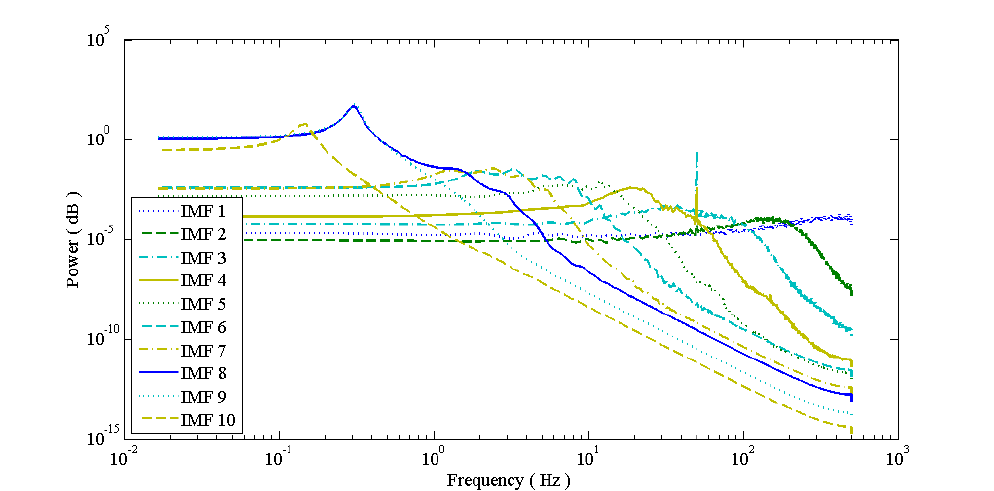
Figure 5. Corresponding IMF spectrum distribution of (a) EMD, and (b) EEMD of Figure 4. The x-axis unit is Hz, y-axis is power. There is less spectrum overlapping of EEMD than EMD due to reduction of mode mixing in